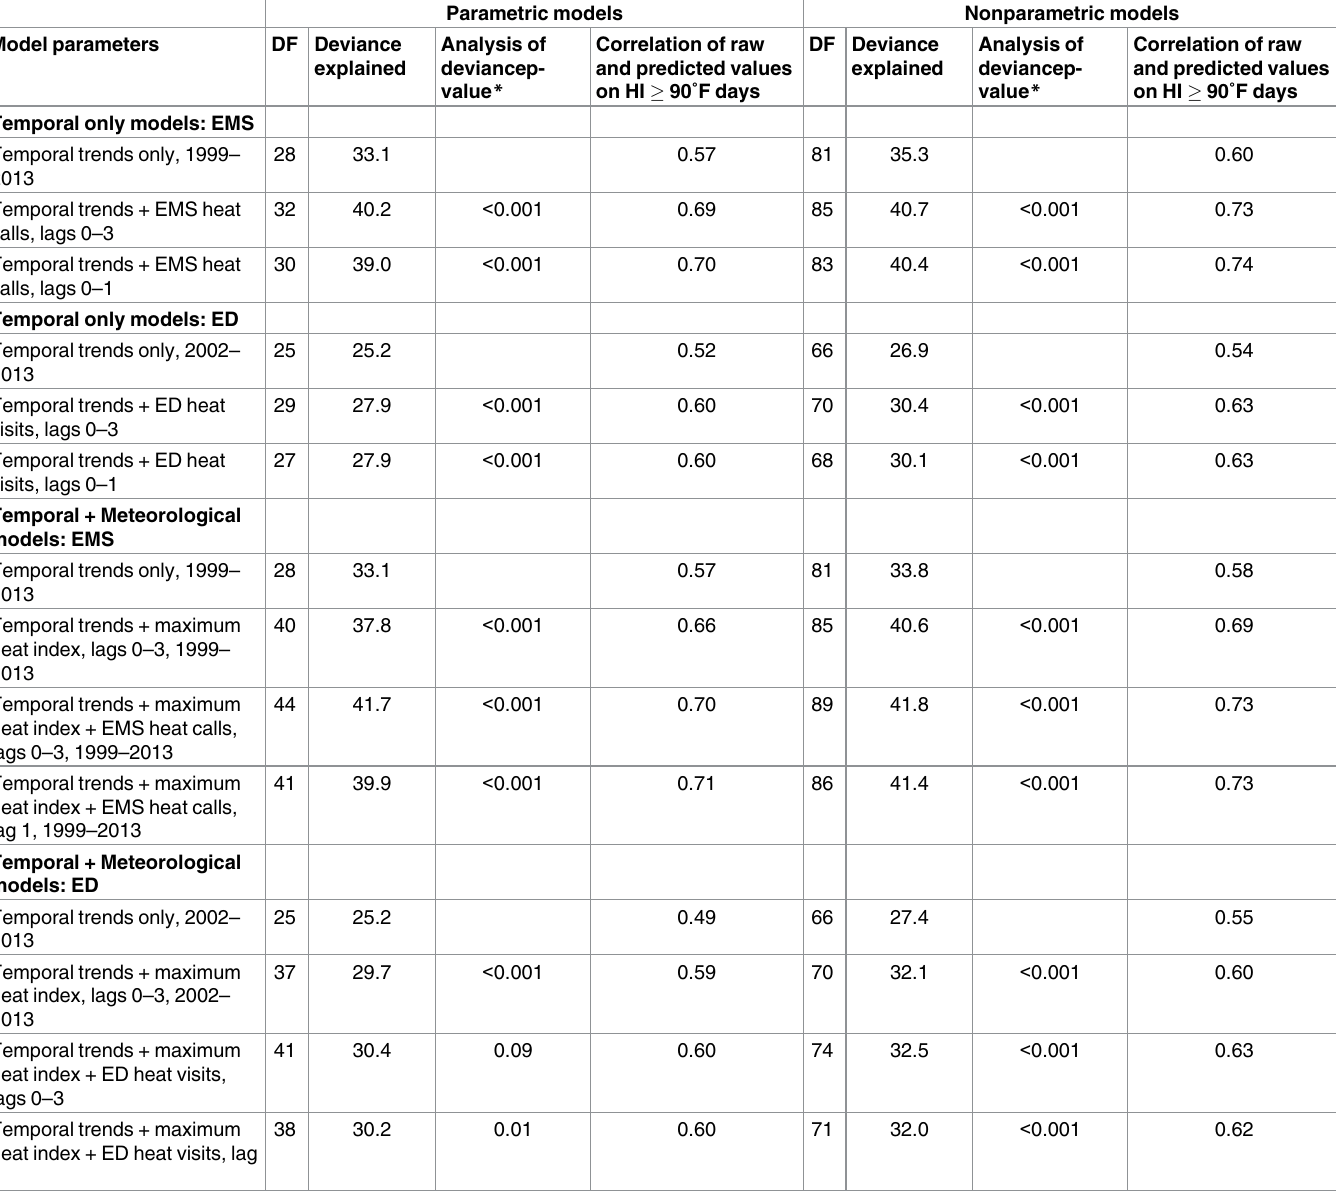
Table 2. Comparison of fit for models of the relation of heat-related EMS calls and ED visits and non-external cause mortality. Parametric